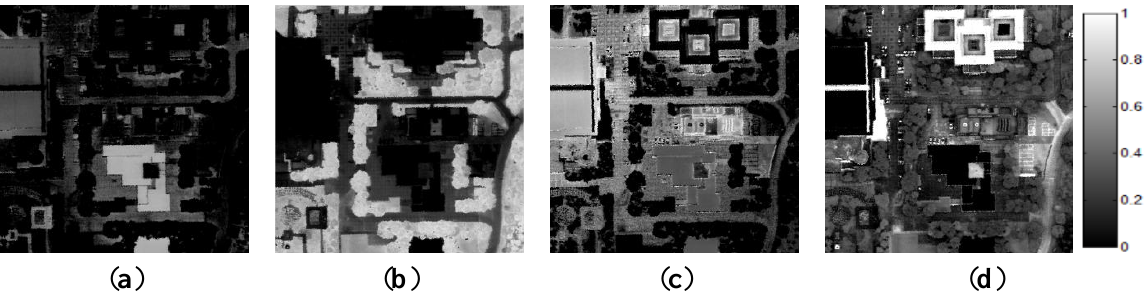
Figure 12. Abundance maps of the final endmembers in the CASI data obtained using the proposed method. ( a ) 𝑬